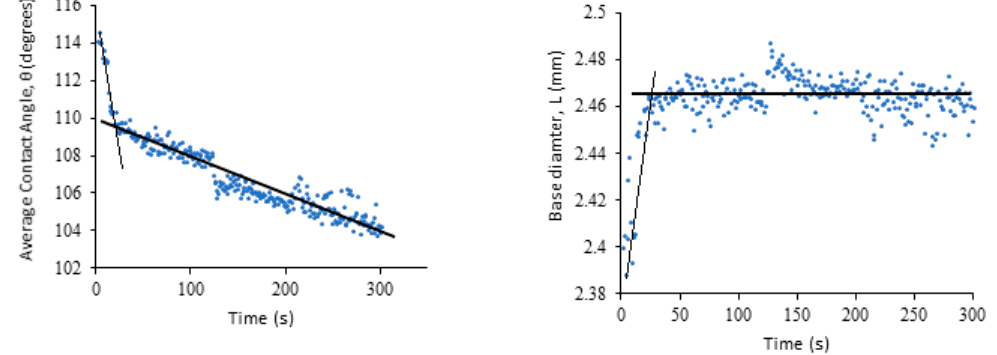
Figure 3. Contact angle and droplet base diameter time dependencies for distilled water on dry dish sponge. Both plots show the presence of stages 1 and 2 according to the partial wetting case in Figure 1.